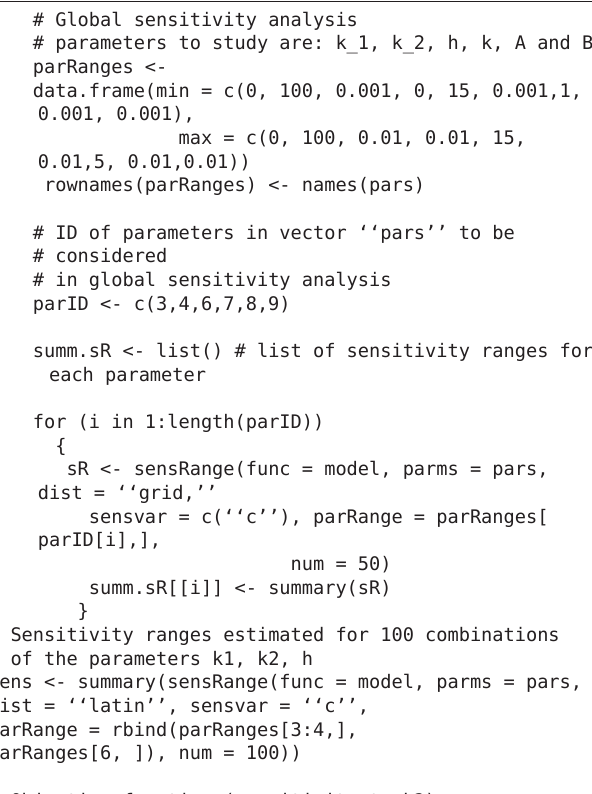
TABLE 2 | R functions implementing the sensitivity analysis of the model of Equations (15)–(16). # Global sensitivity analysis # parameters to study are: k_1, k_2, h, k, A and B parRanges <- data.frame(min = c(0, 100, 0.001, 0, 15, 0.001,1,